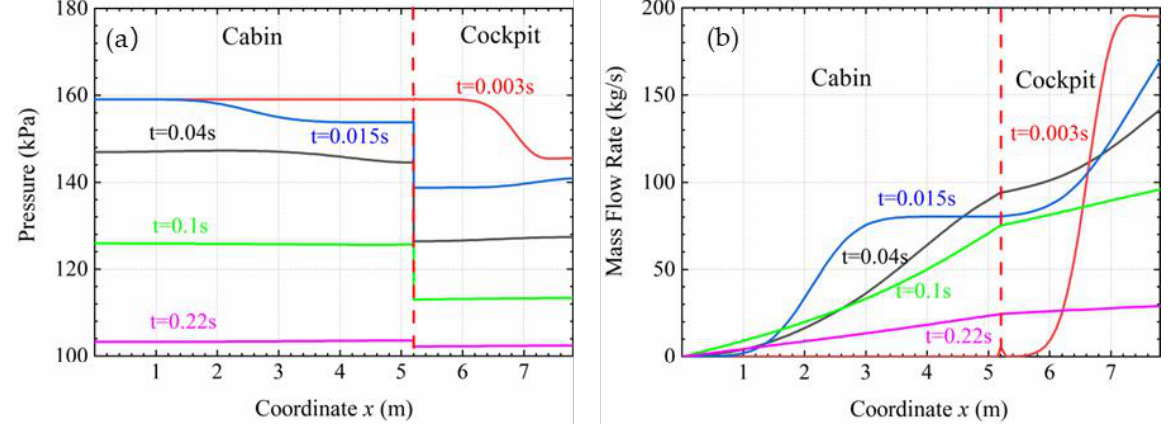
Figure 13. ( a ) Pressure distribution and ( b ) mass flow rate distribution at 6 characteristic moments, predicted by 1-D models.